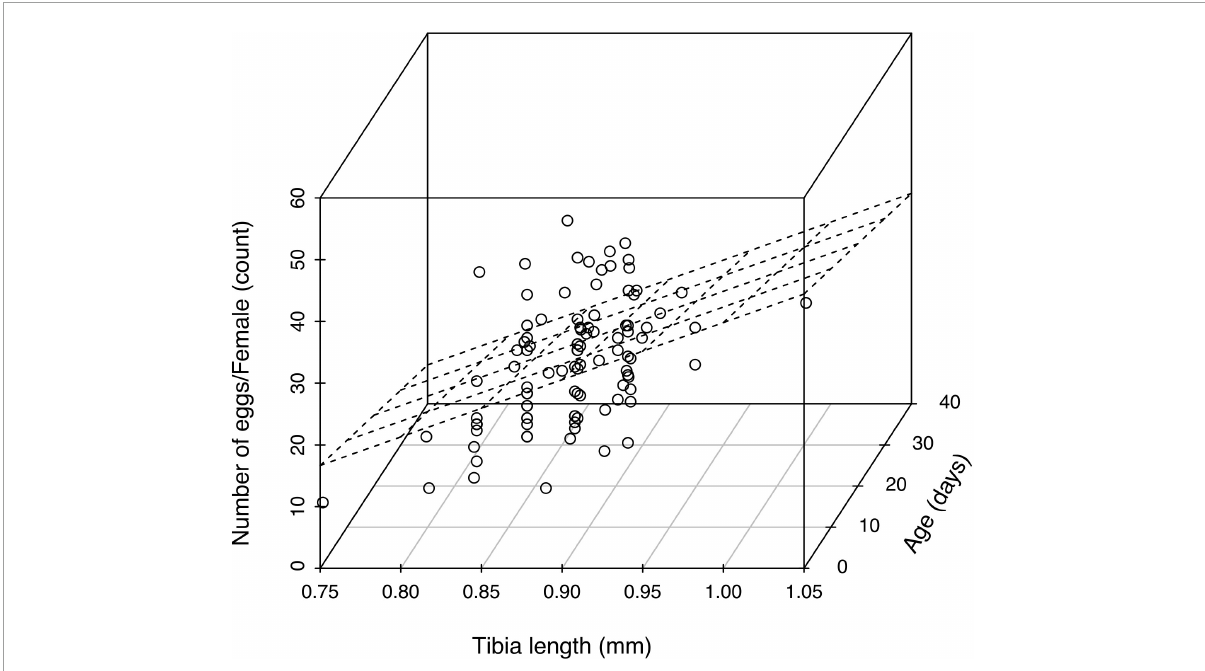
FIGURE3 Three-dimensional scatterplot with regression plane of the effect of tibia length and longevity on egg load. Egg load = –52.77 + 92.58 (tibia) –0.26 (age), R 2 = 0.1816, tibia p = 0.0001, age p = 0.0032.